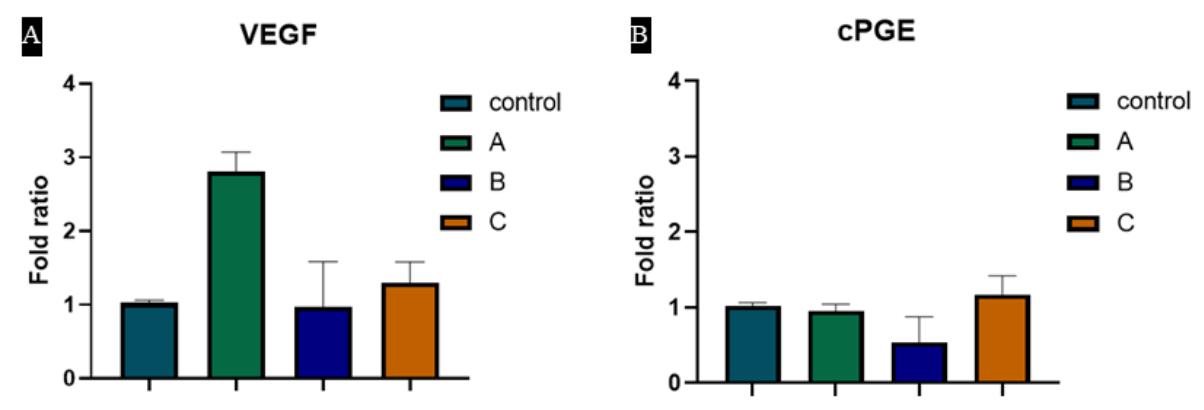
Figure 6. Expression of ( A ) VEGF and ( B ) cPGE synthase in different heparin (1 µg/mL, 5 µg/mL and 10 µg/mL) loaded hydrogels.